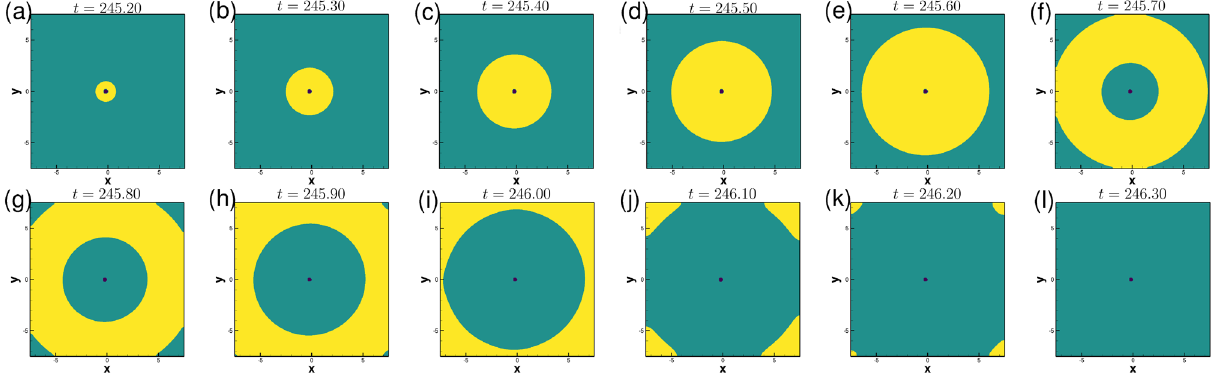
Figure 14. Pattern evolution for γ = − 0.01 with the circular obstacle at a later time between 245.20 ≤ t ≤ 246.30 with a time increment (cid:31) t = 0.1 between two consecutive patterns.